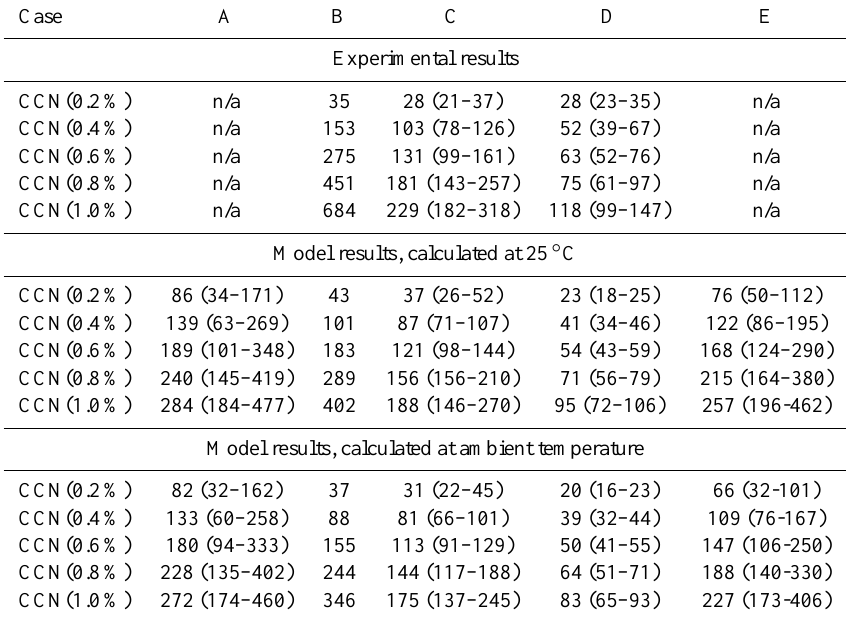
Table 2. Measured and calculated CCN concentrations averaged over the duration of an event. The minimum and maximum values are shown in